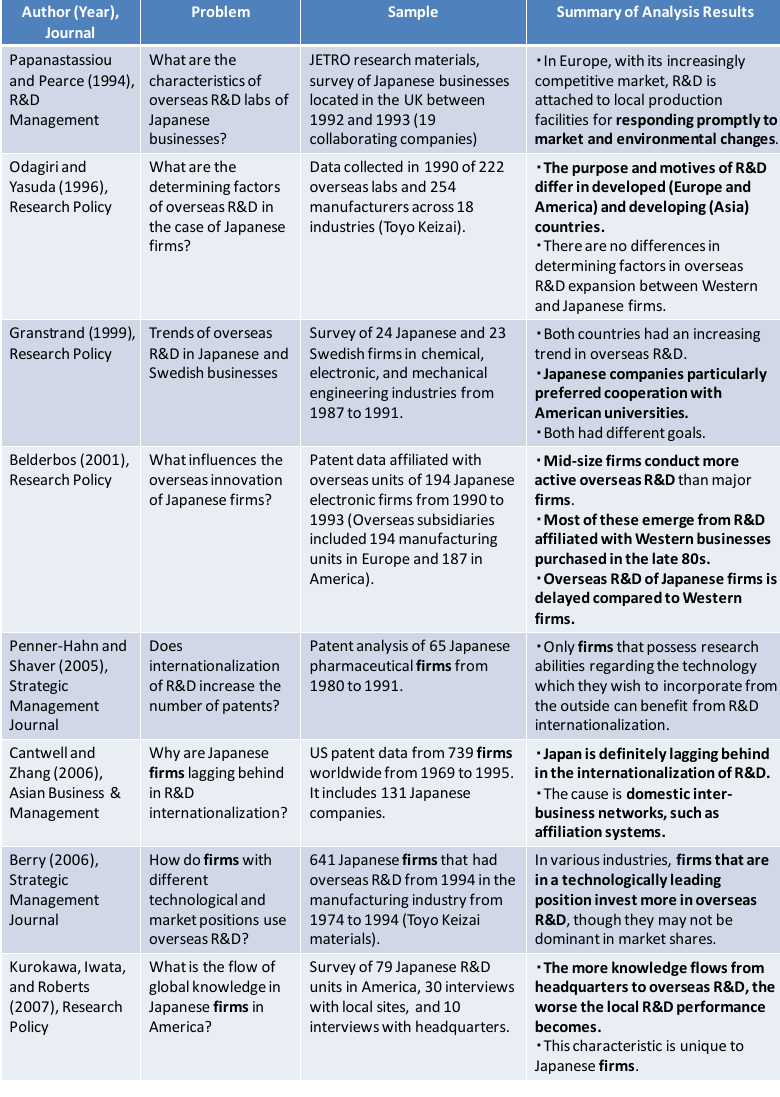
Table 2. Summary of researches on global R&D of Japanese